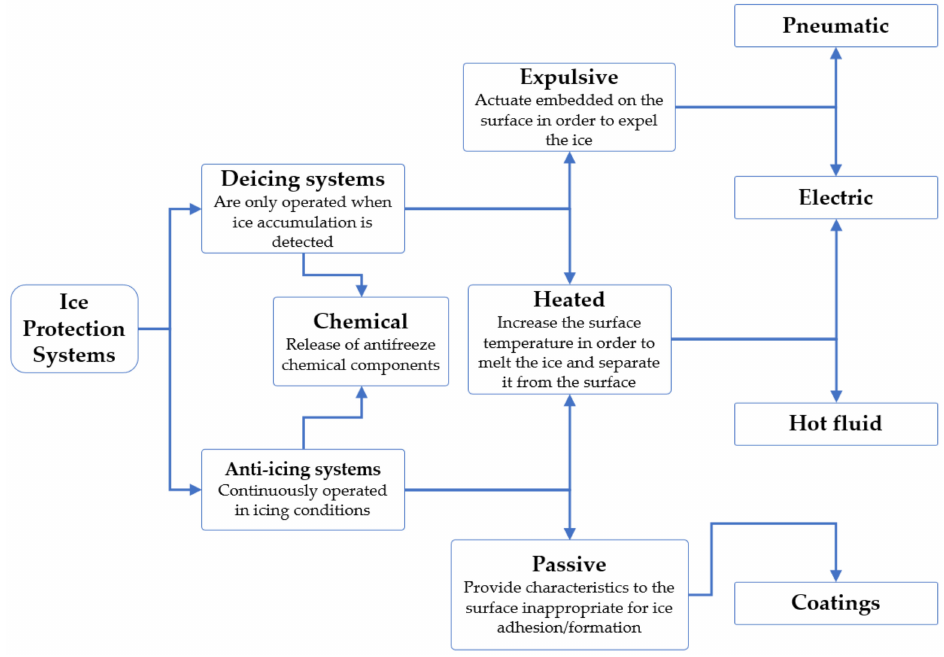
Figure 1. Different anti-icing and deicing techniques generally used in ice protection